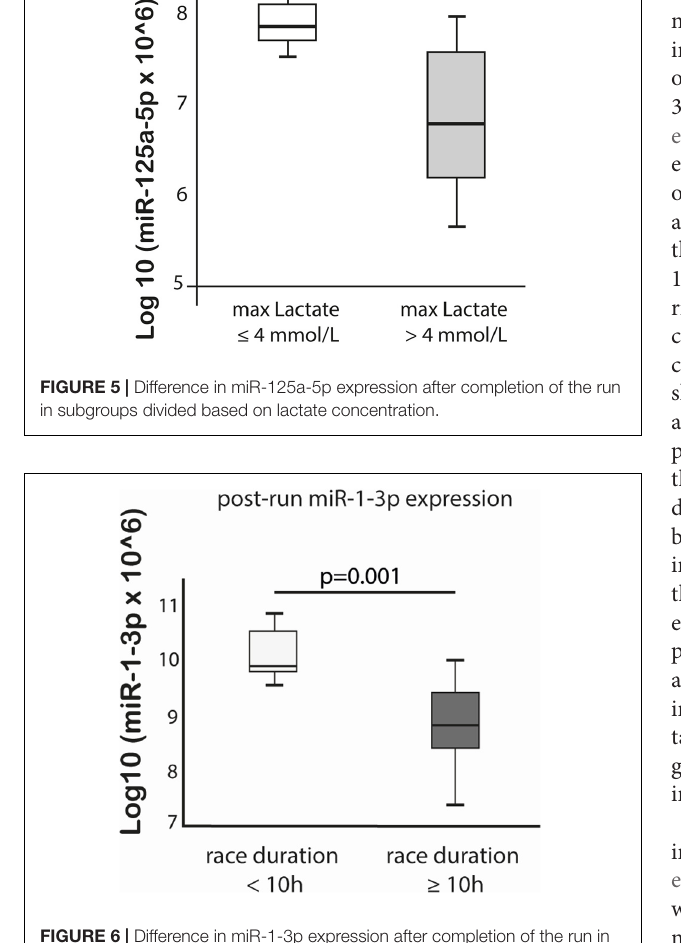
FIGURE 6 | Difference in miR-1-3p expression after completion of the run in subgroups divided based on race duration cut-off 10